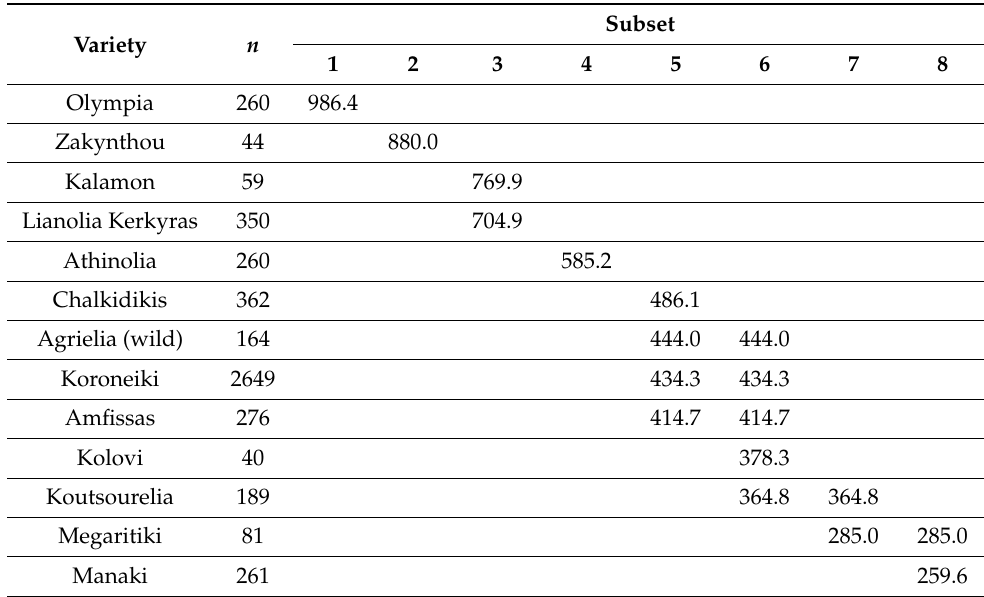
Table 4. Comparisons of Total Phenols means (mg/kg) for each variety using Duncan’s multiple range test ( a = 0.05) (varieties reside in the same subset are not statistically different).